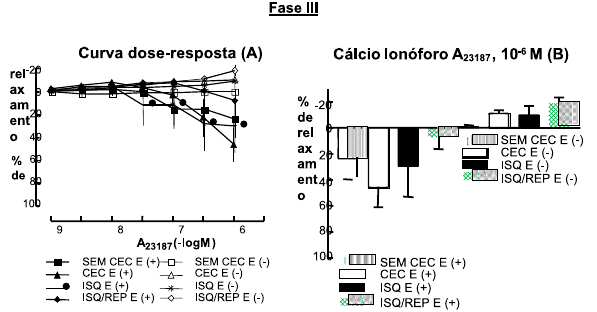
Fig. 9 - Fase III (Krebs com magnésio restaurado): A - Curvas ) em anéis de artérias dose-respostas ao cálcio ionóforo (A 23187 coronárias caninas, contraídas com PGF a (2 x 10 -6 M), na presença 2 de indometacina (10 -5 M) - Fase I (Krebs com magnésio). B - Efeitos ) em anéis de artérias da dose 10 -6 M de cálcio ionóforo (A 23187 coronárias caninas, contraídas com PGF2a (2 x 10-6M), na presença de indometacina (10 -5 M) - Fase I (Krebs com magnésio). (SEM CEC = grupo controle, CEC = grupo de animais submetidos a 110 min de circulação extracorpórea, ISQ = grupo de animais submetidos a 45 min de isquemia, ISQ/REP = grupo de animais submetidos a 45 min de isquemia e 60 min de reperfusão, E (+) = anéis com endotélio, E (-) = anéis sem endotélio. Valores em porcentagem de relaxamento sob a forma de médias ± erros-padrão ). (n = 6).